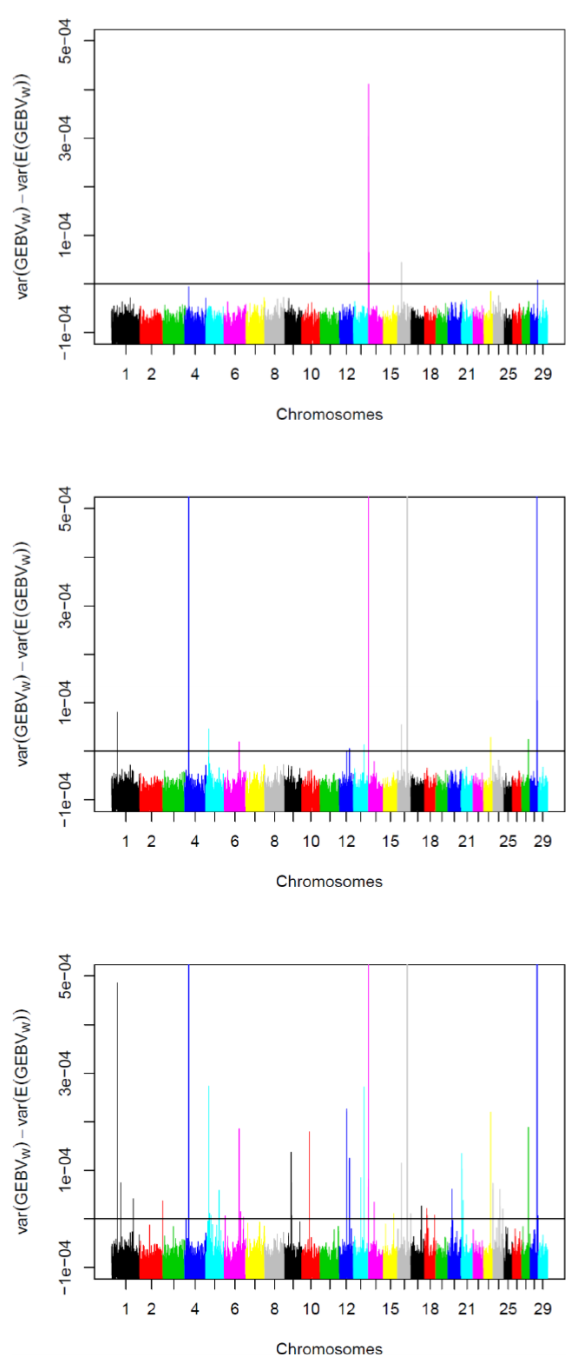
Figure 3. Results of a window-based multi-marker GWASs in a sample of the German Holstein population using the models SNP- BLUP (top panel), BayesA (middle panel) and BayesC (bottom panel). For each window, the deviation of the variance of the ge- nomic estimated breeding value from its expected value is shown. The solid line corresponds to a deviation of